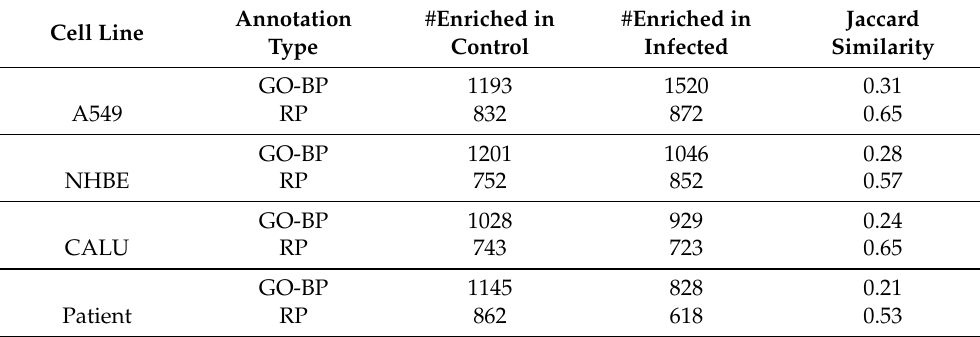
Table 2. Enriched functions in infected and control iCells are different. For each cell line/patient (column 1), we computed the number of enriched functions (GO-BP and RP, column 2) in the control (column 3) and the infected (column 4) cells, and the Jaccard similarity (column 5) between the enriched functions in the control and the infected